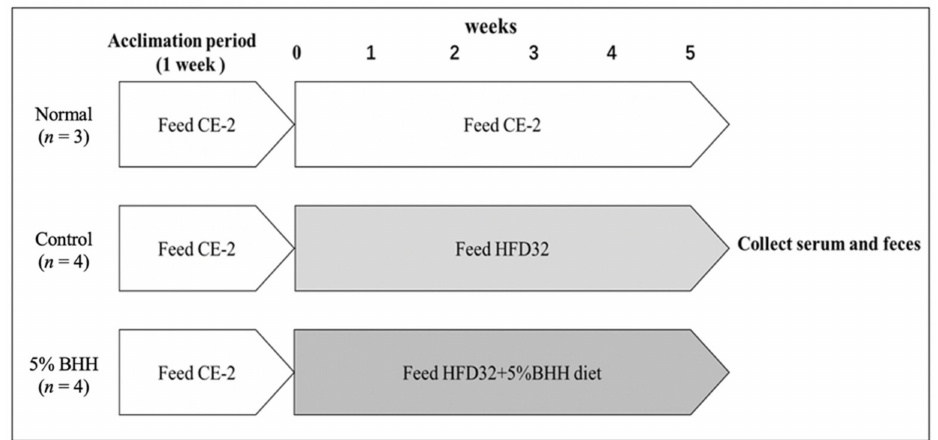
Figure 1. Experimental design. Eleven male C57BL/6JJcl mice (CLEA Japan Tokyo) of 9 weeks were used and the experiments were conducted after an acclimation period of 1 week. Normal, Normal group ( n = 3); Control, Control group ( n = 4); 5% BHH, Bamboo hemicellulose hydrolysate group ( n =